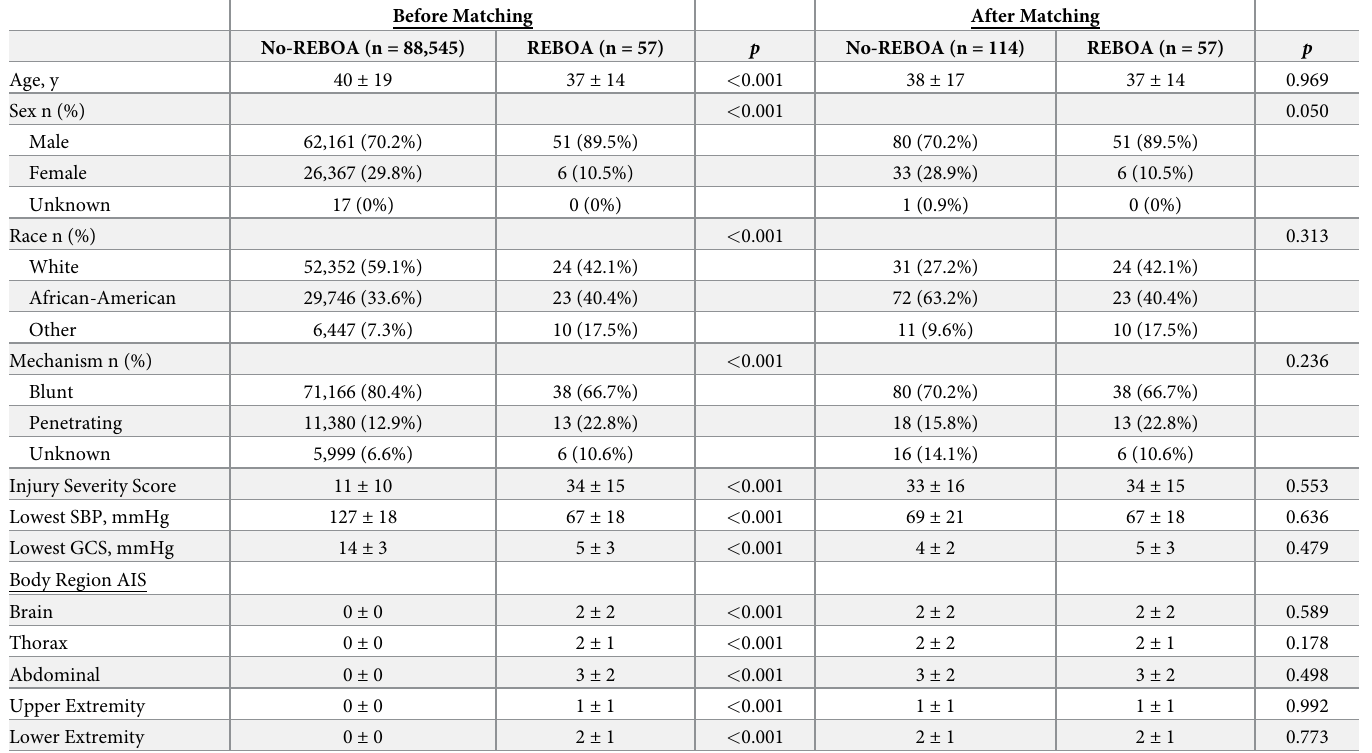
Table 2. REBOA to No-REBOA historic group before and after propensity-matching � .